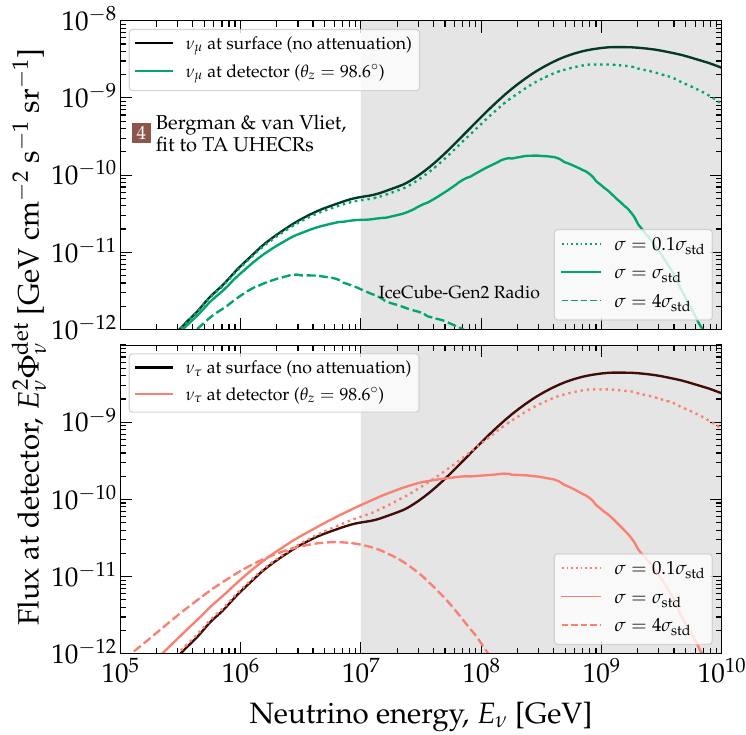
Figure 10 . Benchmark UHE ν µ and ν τ flux model 4 [61] (see section 4) at the surface of the Earth and at IceCube-Gen2, after propagating through the Earth along an illustrative direction, θ The flux of ν , not shown, is similar to that of ν . The effect of in-Earth propagation on the fluxes e µ of ¯ ν ( α = e, µ, τ ), not shown, is similar to the effect ν . Fluxes at the detector are computed using α α NuPropEarth [78, 79]. We show fluxes propagated using the central value of the BGR18 νN DIS cross section ( σ ) [63], and scaled-up and scaled-down versions of it. See section 5 for std